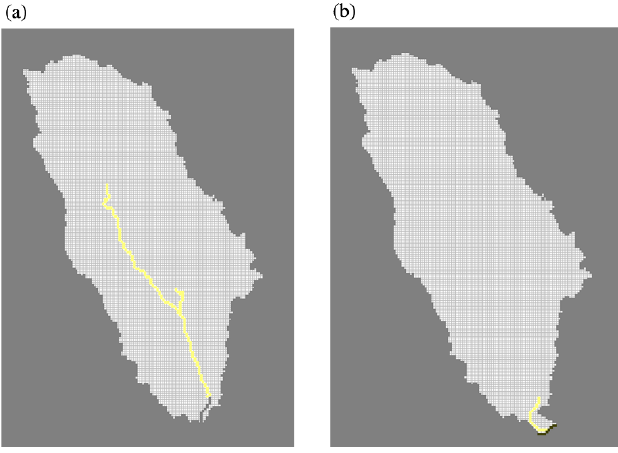
Figure 3. The discretized study area: ( a ) the upper layer; ( b ) the bottom layer. The yellow line represents the location of the river.